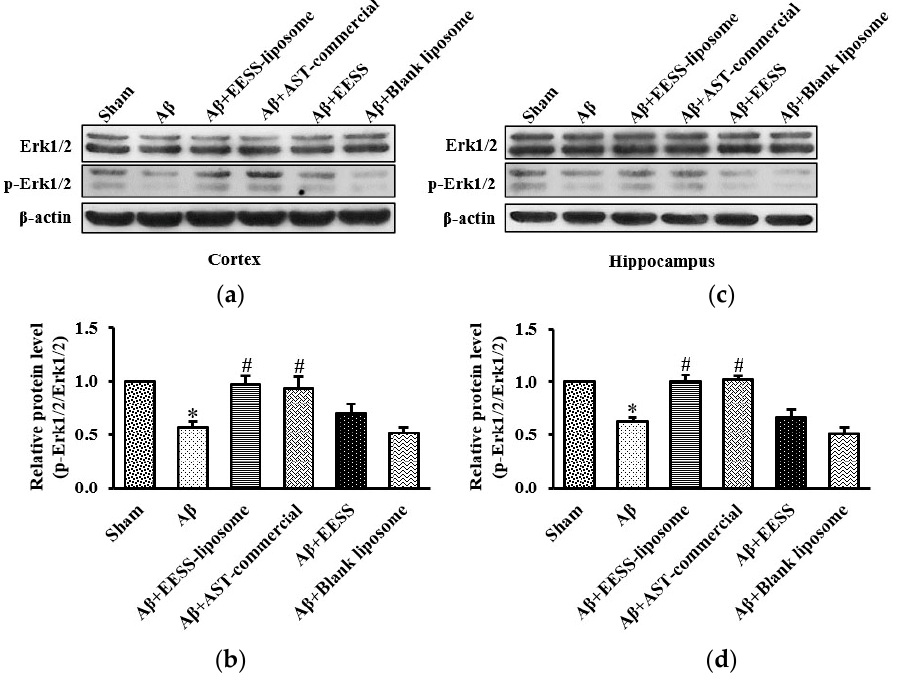
Figure 10. EESS-loaded liposome suppressed A β -induced cognition and synaptic plasticity deficits via Erk signaling pathway. ( a , c ) show representative images of Western blot analy- sis of p-Erk1/2/Erk1/2 in the cortex and hippocampus, respectively. ( b , d ) show the relative p-Erk1/2/Erk1/2 levels in the cortex and hippocampus, respectively. Data were presented as means ± SEM. * indicates significant difference ( p < 0.05) between A β and sham groups; # indicates significant difference ( p < 0.05) between EESS-loaded liposome, AST-commercial and A β groups; n = 5